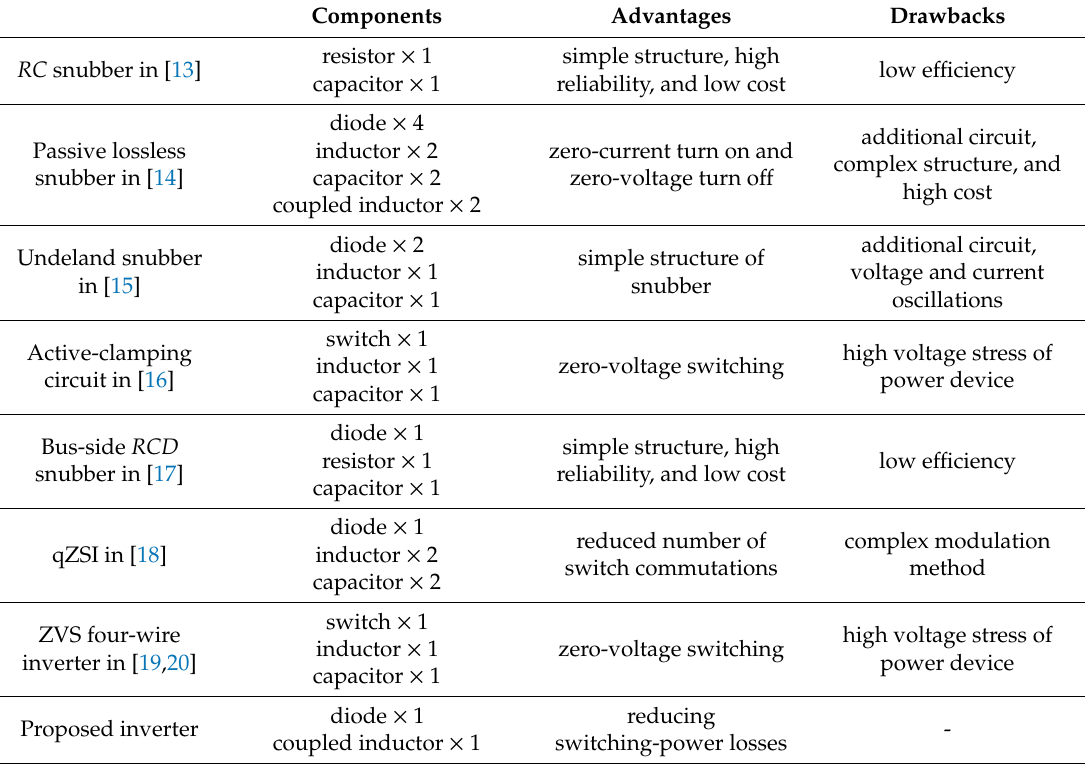
Table 3. Comparison results of di ff erent approaches for reducing switching-power losses. Components Advantages Drawbacks simple structure, high RC snubber in [13] additional